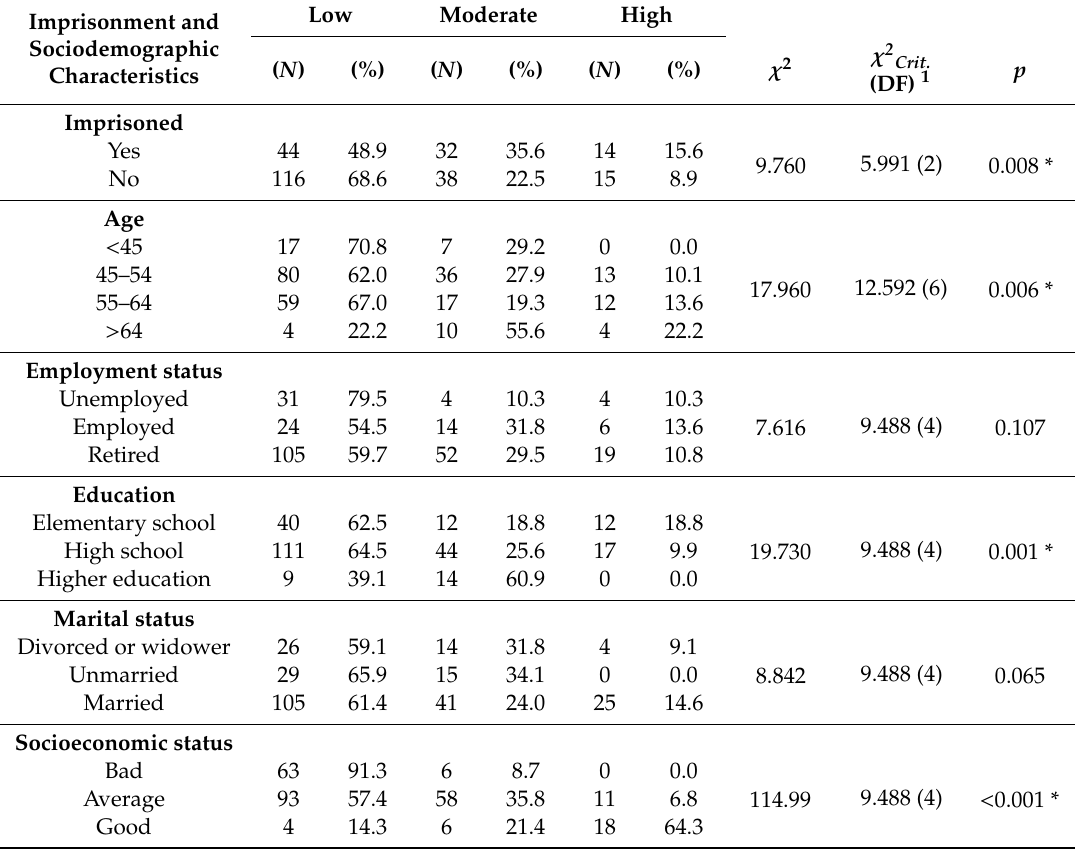
Table 2. Di ff erences in the veterans’ perception of social support associated with di ff erent sociodemographic